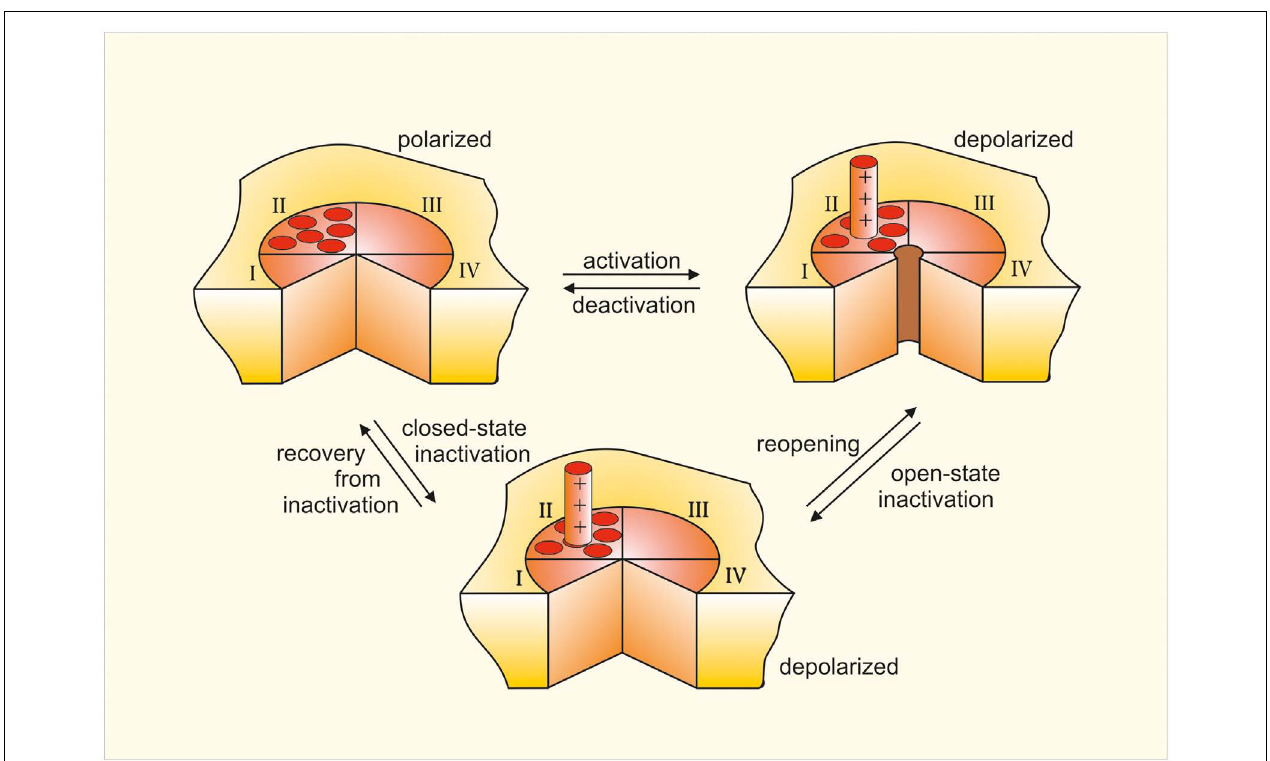
pore.The model also shows one of the four voltage sensors S4, which moves outward when the membrane becomes depolarized and remains in this position until